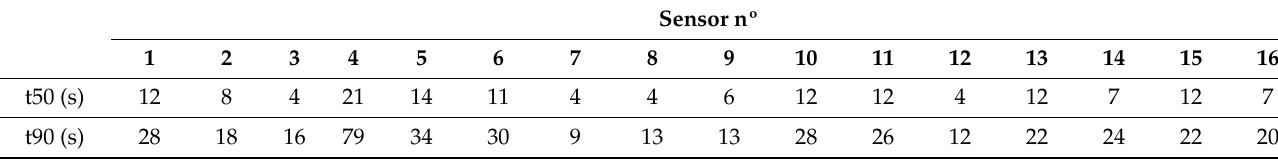
Figure 3. Time of response for sensors 19 to 16. Table 3. Times at which 50% and 90%, respectively, of the final gas concentration, are achieved.